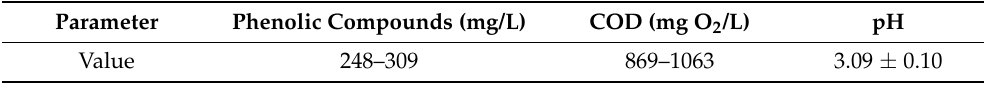
Table 2. Synthetic OMW (Trans-cinnamic acid, 3,4-Dihydroxybenzoic, 4-Hydroxybenzoic,